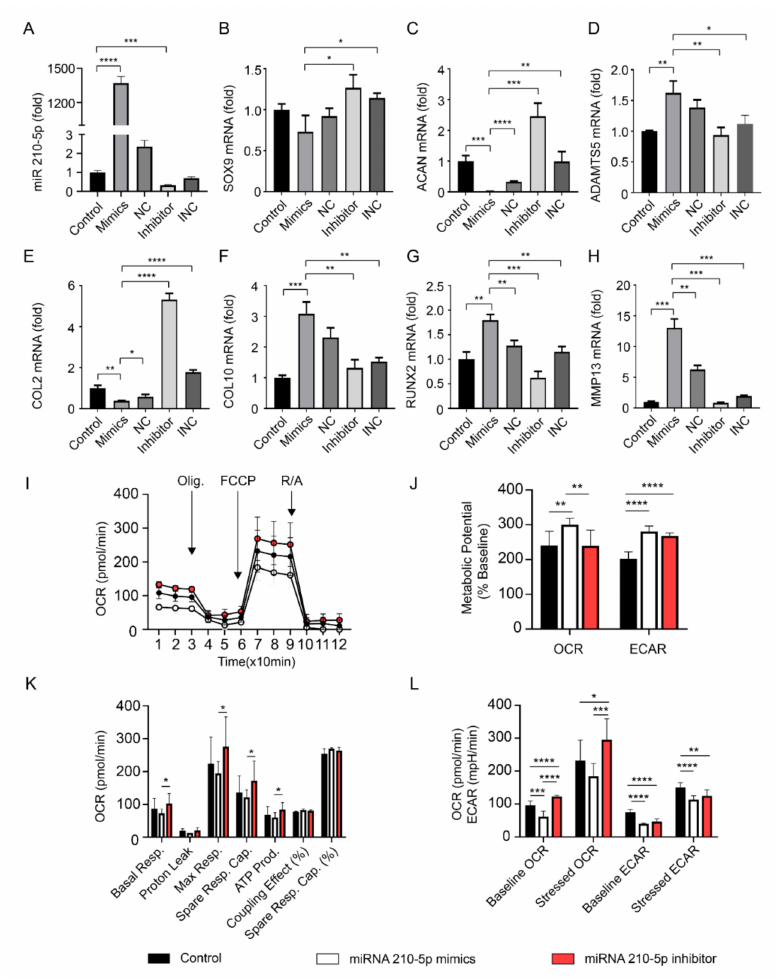
Figure 4. MiR-210-5p leads to hypertrophic change and cellular aerobic respiration alteration in chondrocytes. ( A ) The expression of miR-210-5p in chondrocytes after transfection (n = 3 patients). NC, negative control; INC, inhibitor negative control. ( B – H ) Real-time PCR of gene expression in chondrocytes after transfection (n = 3). ( I – L ) Seahorse mitochondrial stress and phenotype analysis of ACCs transfected by miR-210-5p mimics and inhibitor (n = 3). * p < 0.05, ** p < 0.01, *** p < 0.001, **** p <